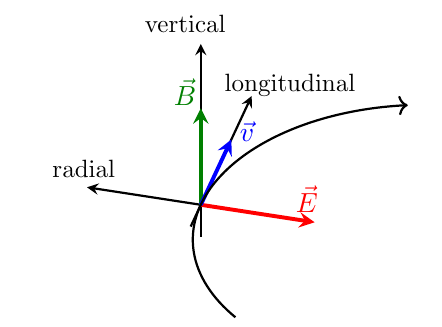
Fig. 1 Illustration of the coordinate system